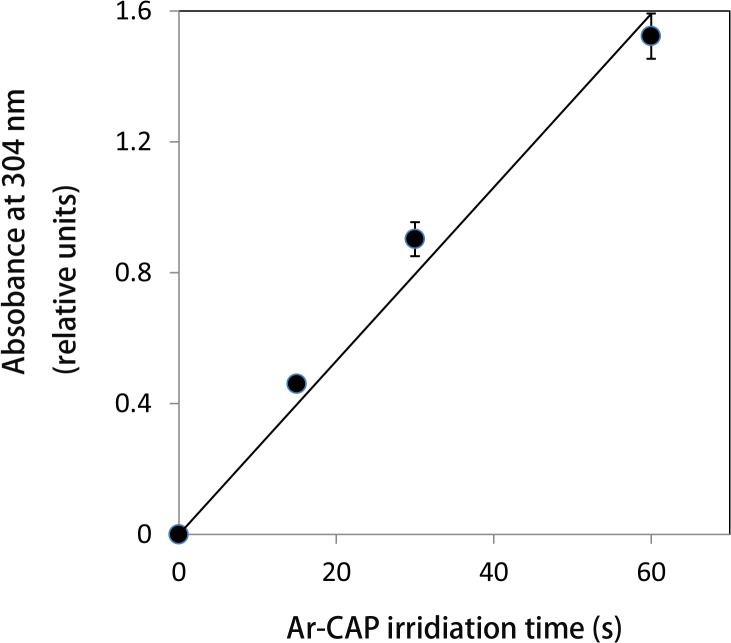
Fricke dosimetery.The effect of different Ar-CAP exposure time on the oxidation of ferrous ions to ferric ions. The oxidation increased linearly with increasing plasma irradiation time.